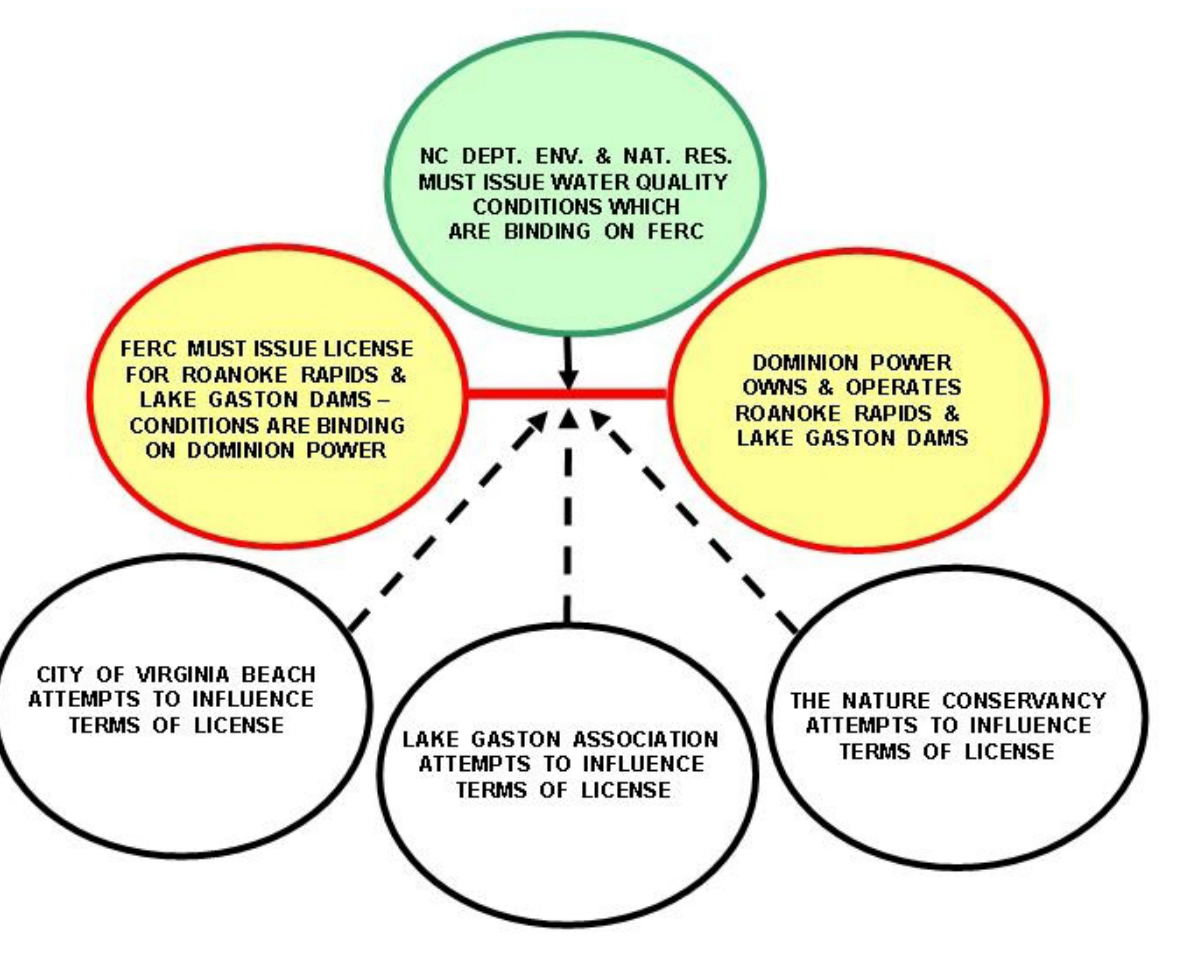
Fig. 4 . Federal Energy Regulatory Commission (FERC) and Dominion Power